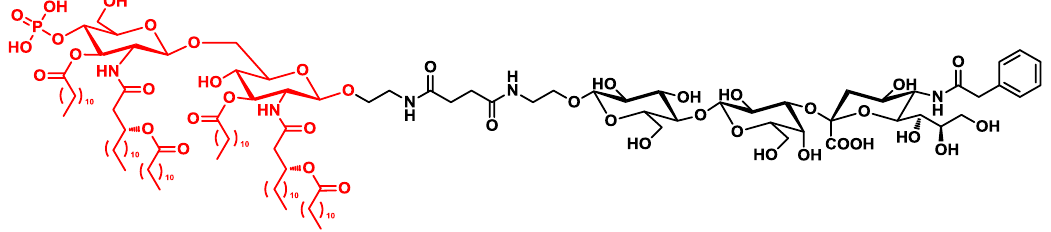
Figure 3. Guo’s vaccine consisting of the carbohydrate antigen and the TLR4 agonist